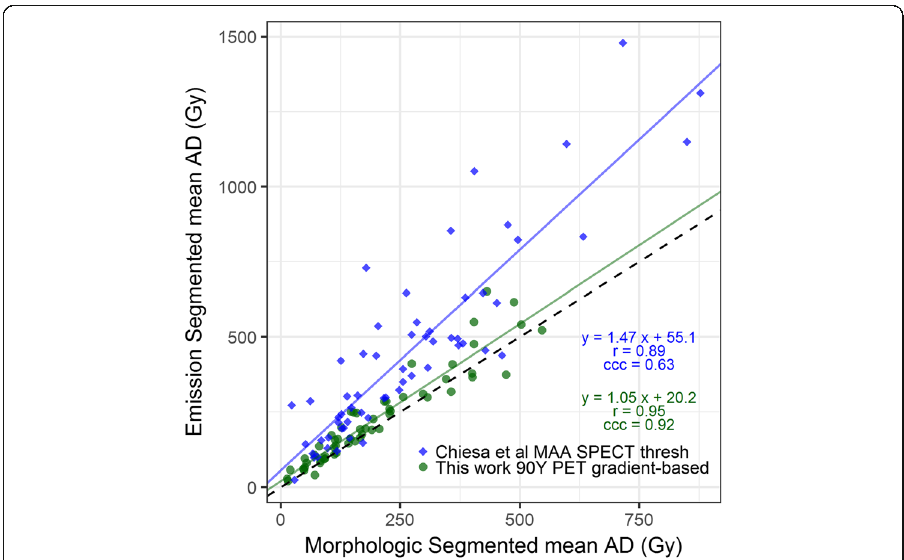
Fig. 7 Showing our PS vs MS for mean tumor AD alongside 99m TcMAA SPECT threshold-based segmentation vs MS for mean tumor AD data from Chiesa et al.